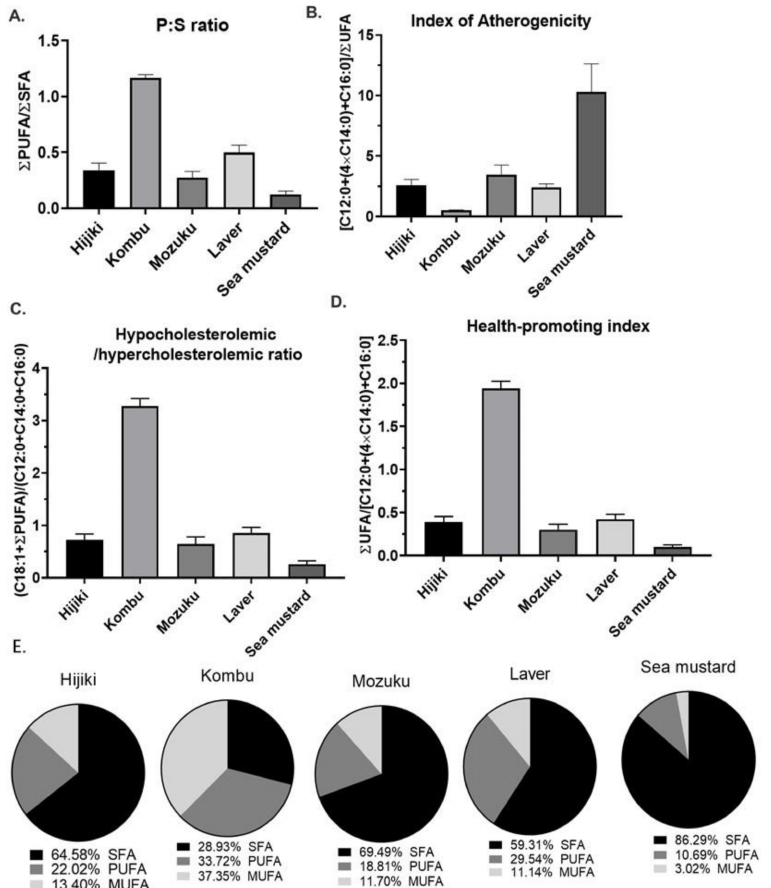
Figure 3. Nutritional indices and percentage distributions of free fatty acids. ( A ) Ratio of PUFA to SFA (P:S ratio). ( B ) Index of atherogenicity. ( C ) Hypocholesterolemic/hypercholesterolemic index. ( D ) Health promotion index. ( E ) Pie charts of percentage distributions of SFA, MUFA, and PUFAs among five types of